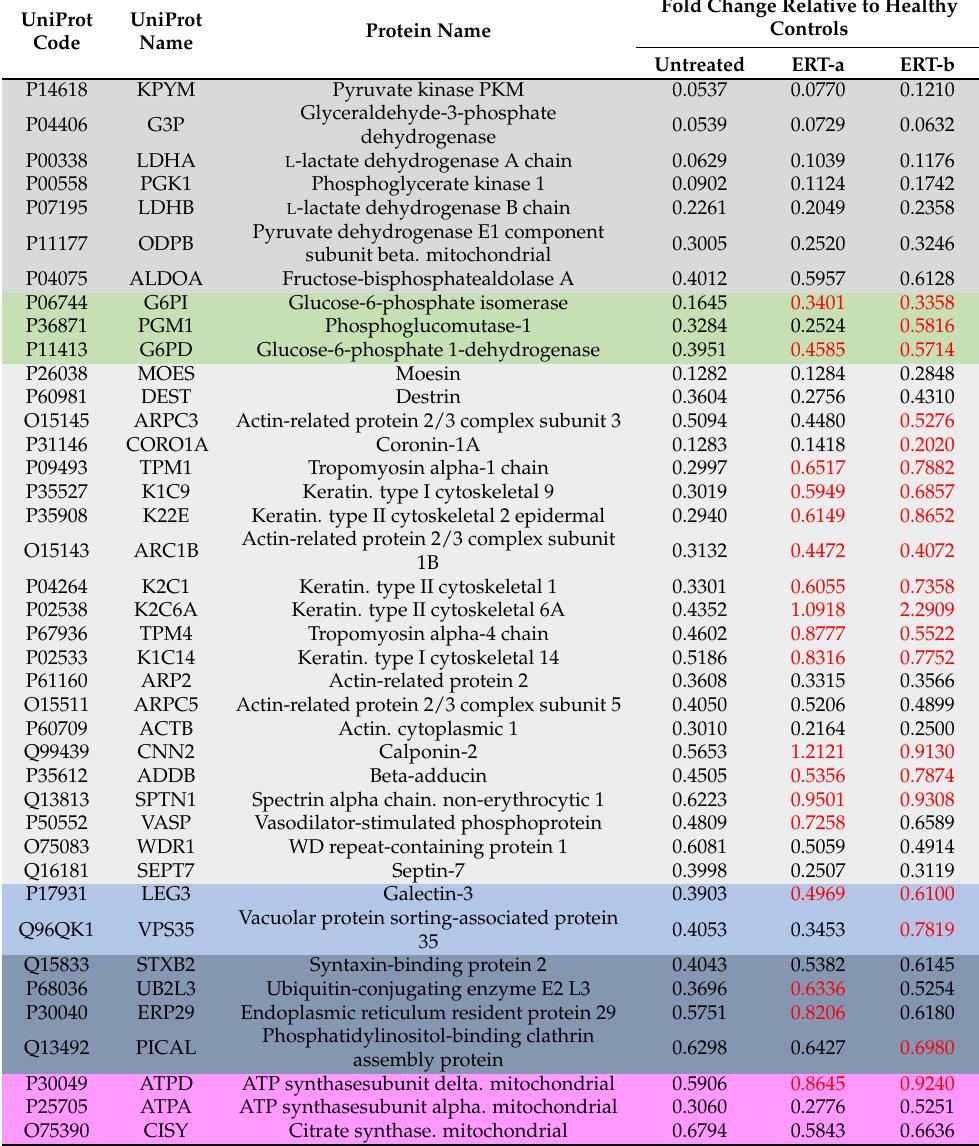
Table 4. Downregulated proteins in untreated and ERT-treated MPS IVA patients (ERT-a, ERT-b) with respect to healthy controls. Proteins considered dysregulated are those with a p -value < 0.05 and a fold change (FC) >